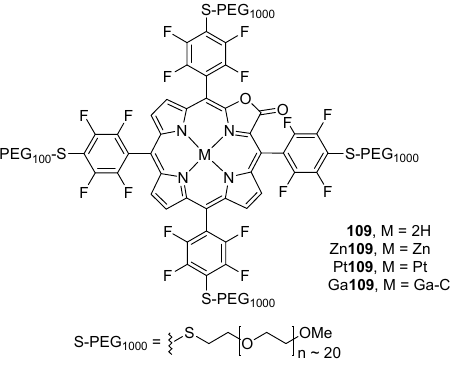
Figure 3. Water-soluble PEGylated porpholactones used as optical cyanide sensors [115].